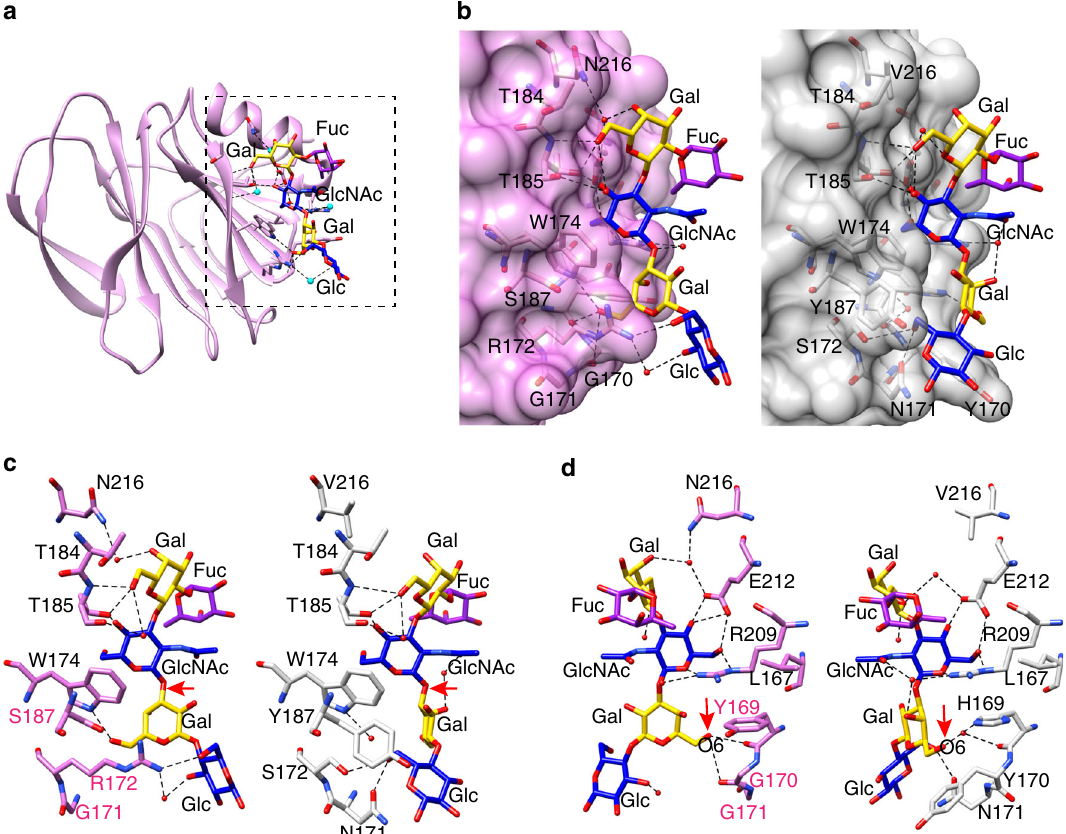
Fig. 5 Structure of P[4] Indian VP8* in complex with H type I pentasaccharide. a Structure of P[4] VP8* is shown in pink ribbon with the bound glycan in stick model. The glycan residues are labeled. b – d Superimposition of the structures of P[4] VP8* (pink)/H-type I and P[6] VP8* (gray)/H-type I. b VP8* in surface representation shows the glycan binding pockets in P[6] and P[8]. c , d The glycan binding residues in P[4] and P[6] are shown in stick model in two views. The rotation of the glycosylic bond between GlcNAc and Gal is indicated with red arrows in c . The interactions between the side chain of H169 in P[6] VP8* and the O6 atom of Gal4, and that of the main chain carbonyl oxygen of Y169 in P[4] VP8* with the oxygen atom O6 of the Gal4 moiety are indicated by red arrows in d